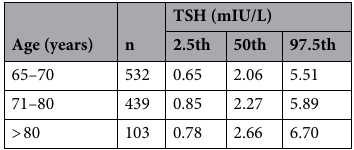
Table 2. Age-specific reference range of TSH in three age groups (n = 1074). TSH, thyroid stimulating hormone.